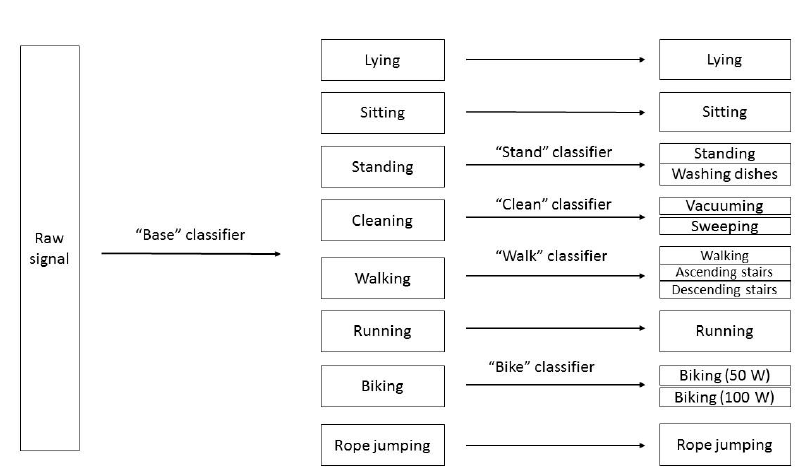
Figure 1. Illustration of our hierarchical classification system.